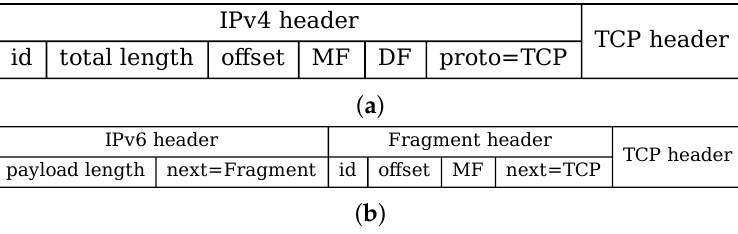
Figure 1. Structure of fragmented IPv4 ( a ) and IPv6 ( b )